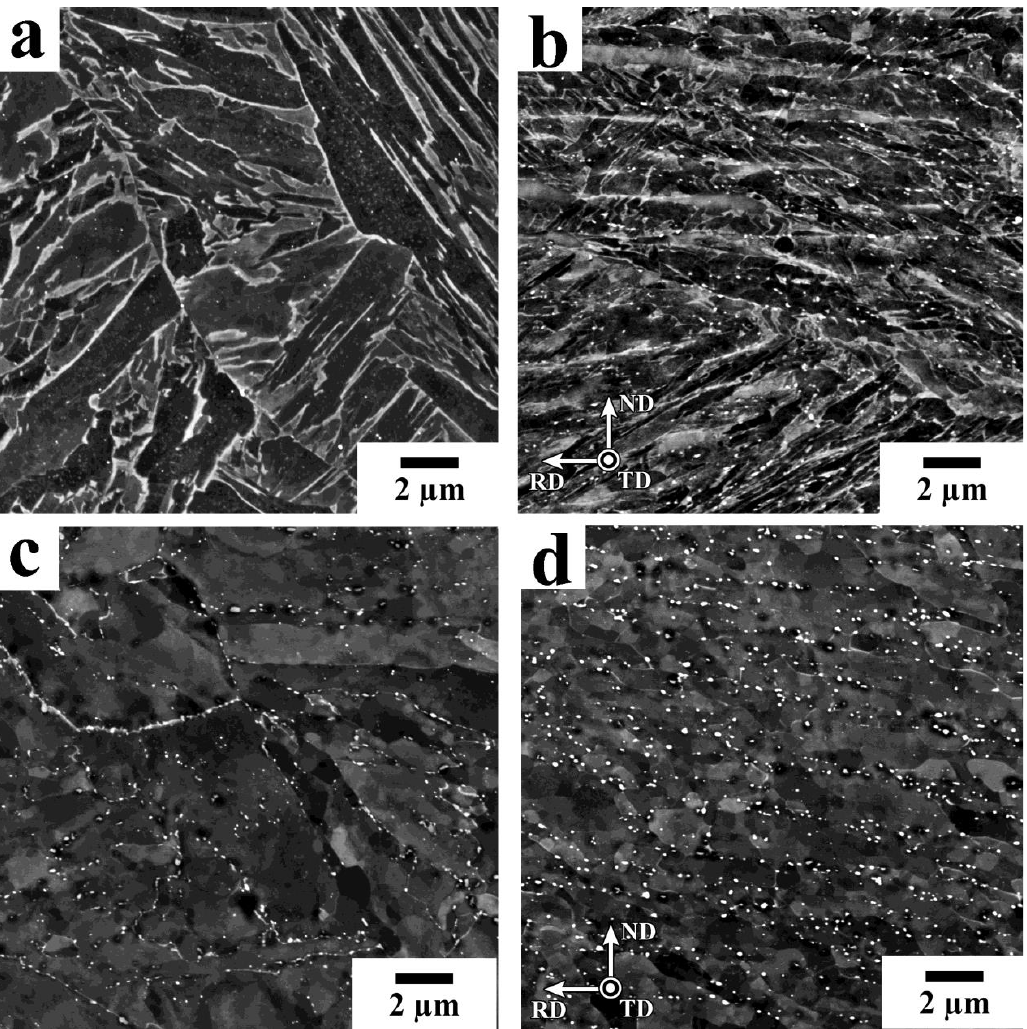
Figure 8. SEM micrographs of the NT ( a , c ) and HR+Q ( b , d ) samples in the untempered condition ( a , b ) and tempered at 780 °C ( c , d ).